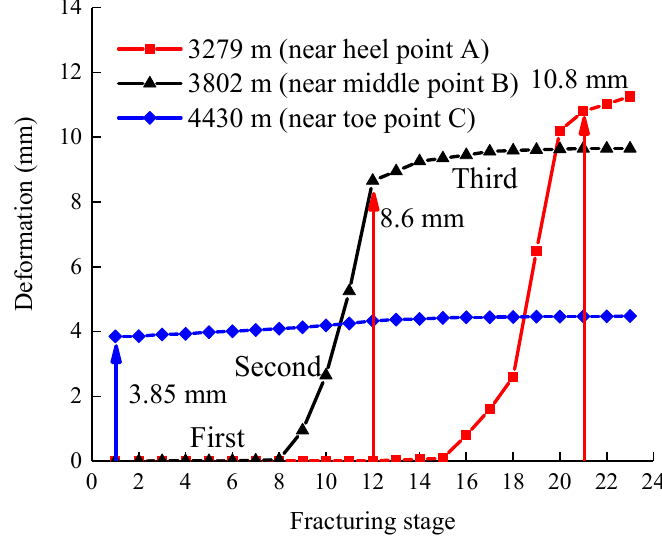
Figure 12. Casing shear deformation in different positions.